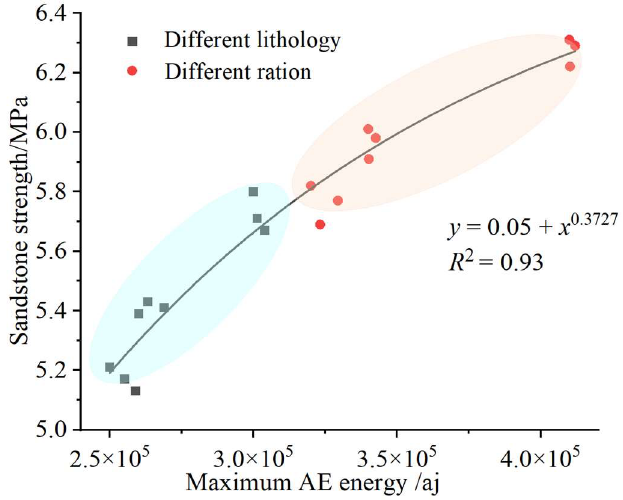
Figure 5. Maximum transient energy versus coal–rock assemblage structure.